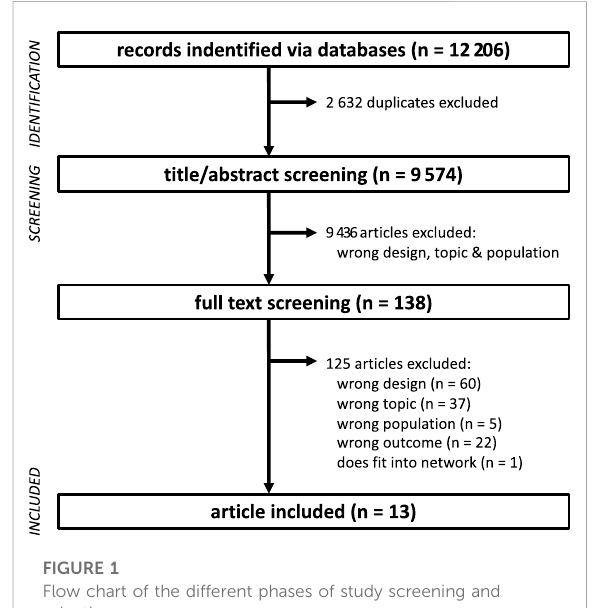
FIGURE 1 Flow chart of the different phases of study screening and